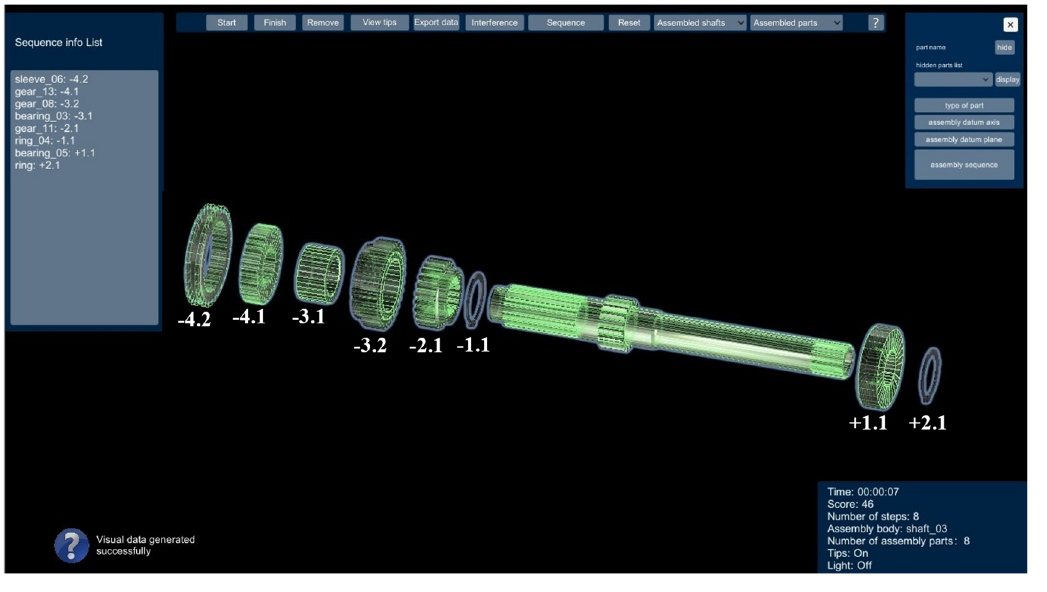
Figure 21. Solid model of the sub − assembly part mesh. Table 9. System generated assembly sequence scheme.